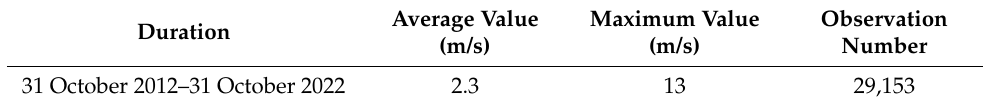
Table 1. Wind speed measurement in Xi’an, 2012–2022.